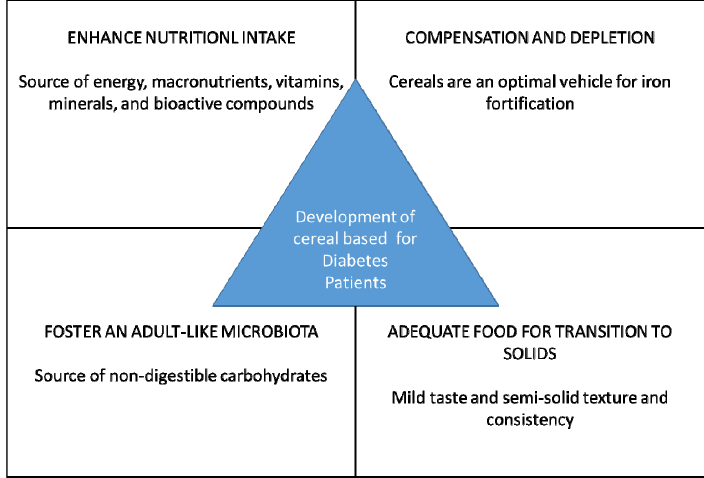
Figure 1. Development of cereal-based products for diabetes patients.